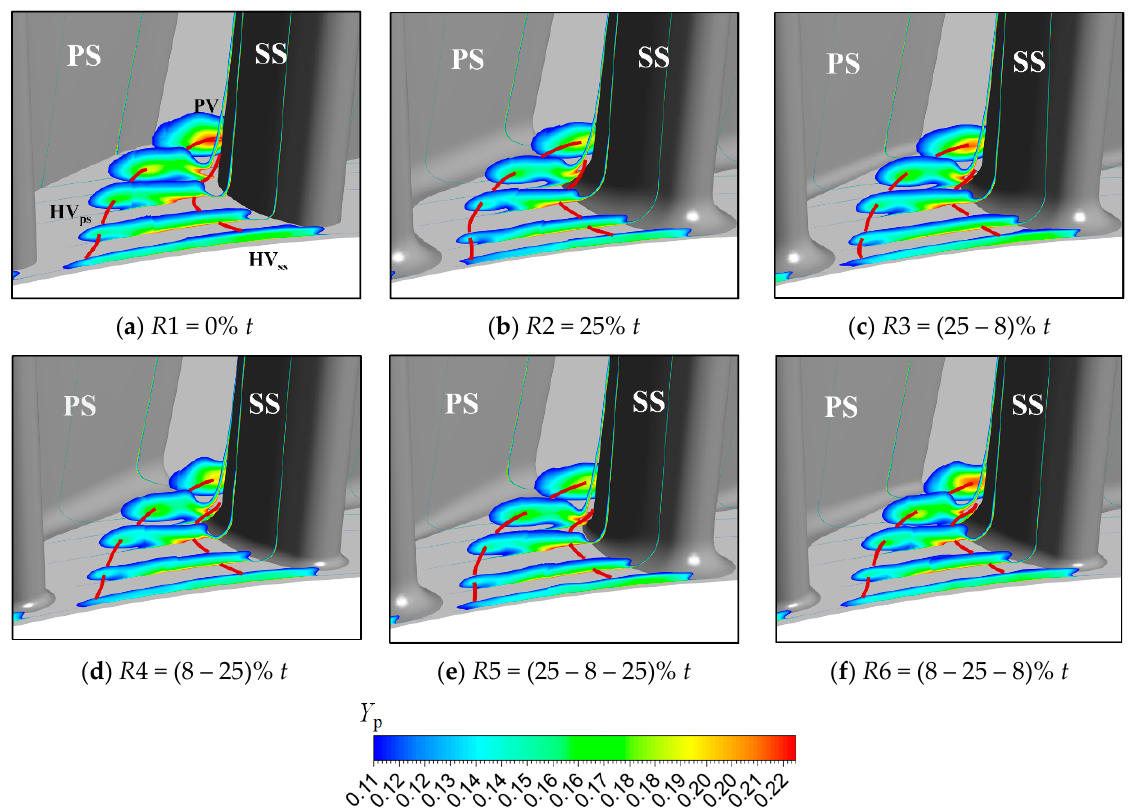
Figure 11. Horseshoe vortex imposed with relative total pressure loss coefficient.